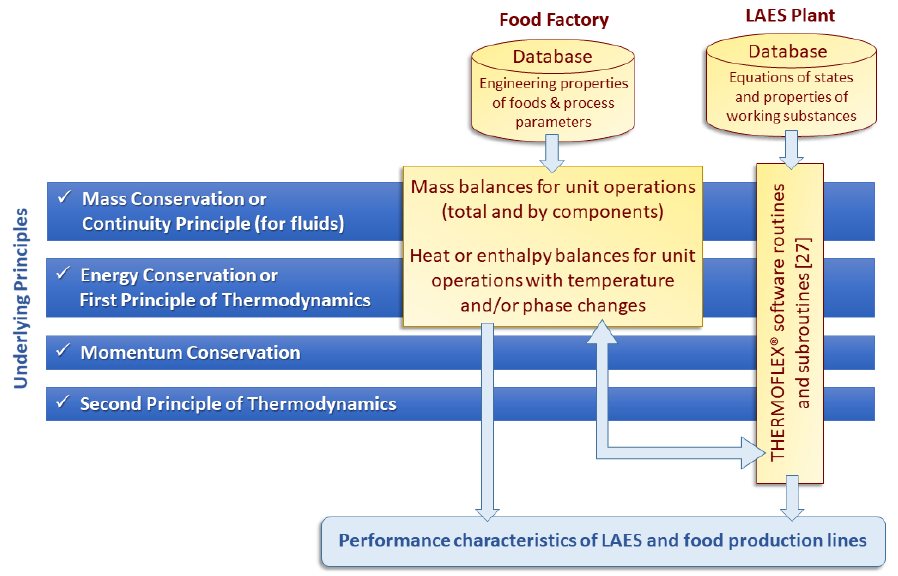
Figure 1. Overall methodology for simulating and quantifying the proposed hybrid system for the synergistic operation of an LAES plant and a food factory.